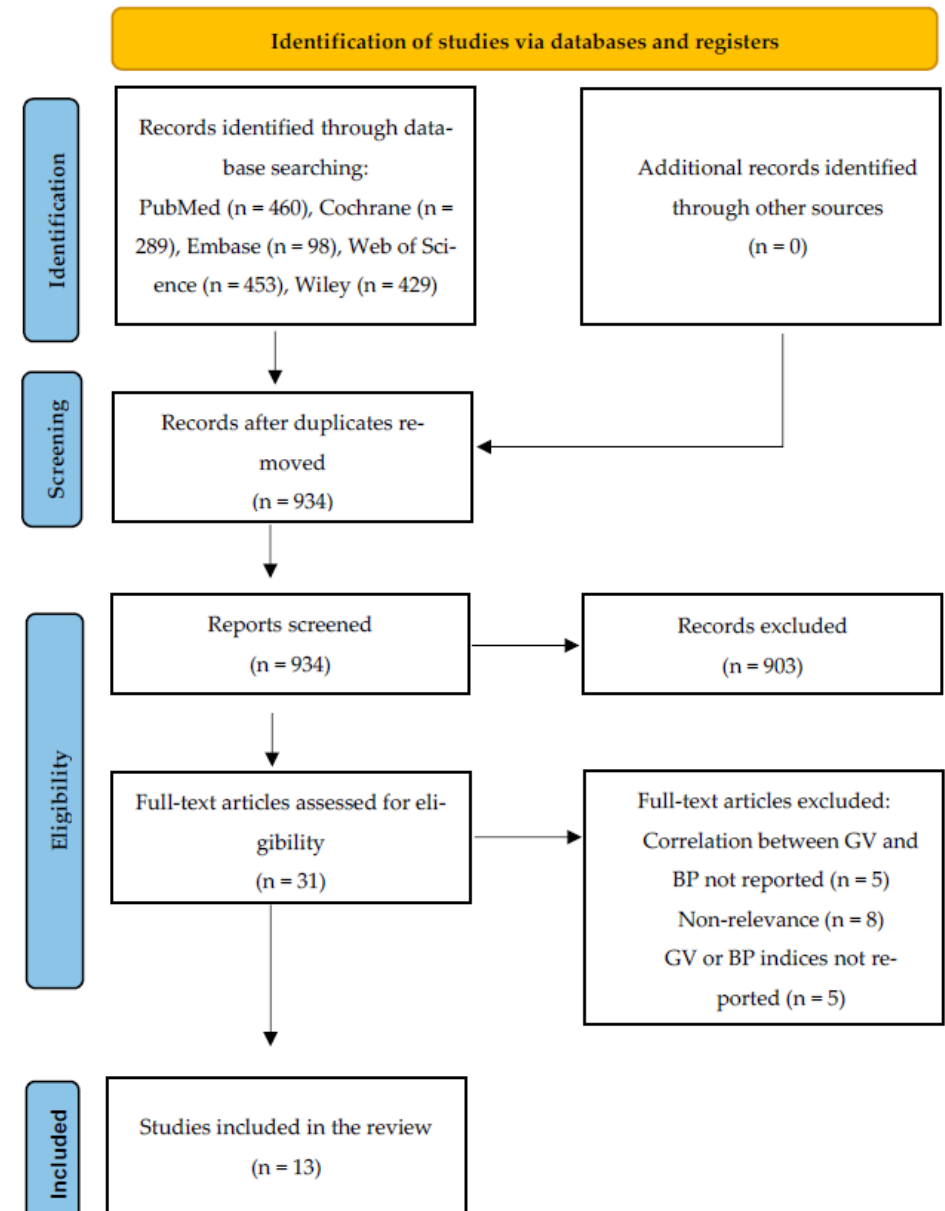
Figure A1. PRISMA Flow Diagram for the Scoping Review Process.